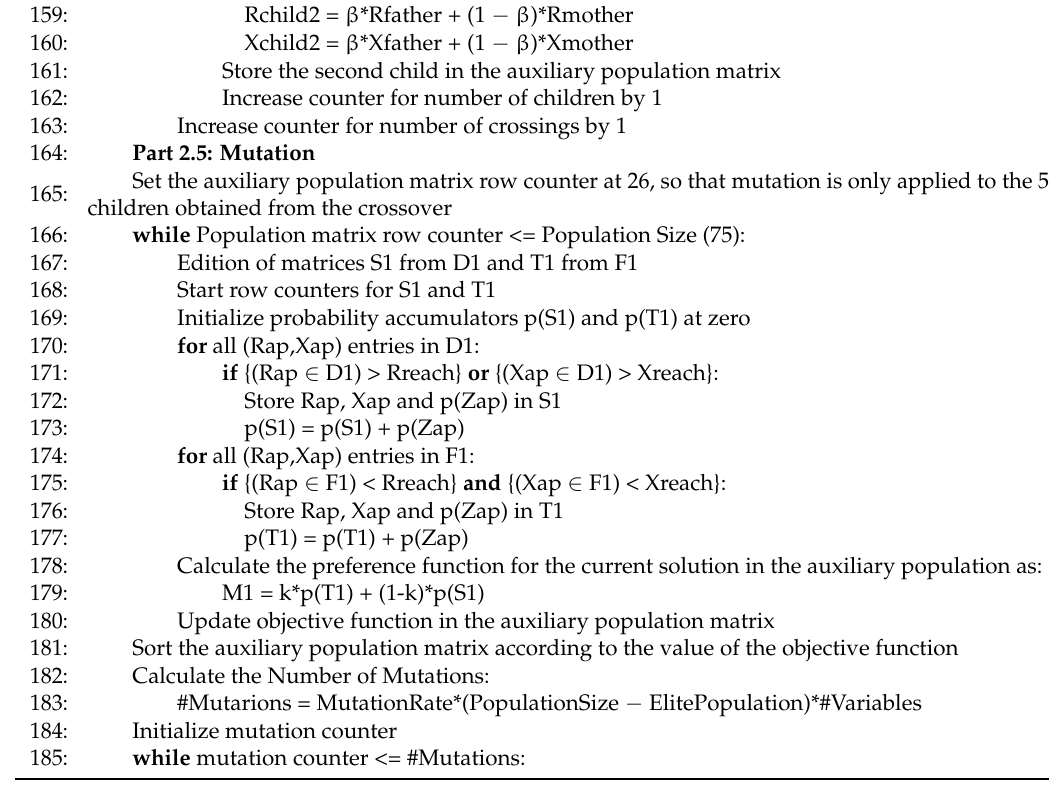
Solution Method